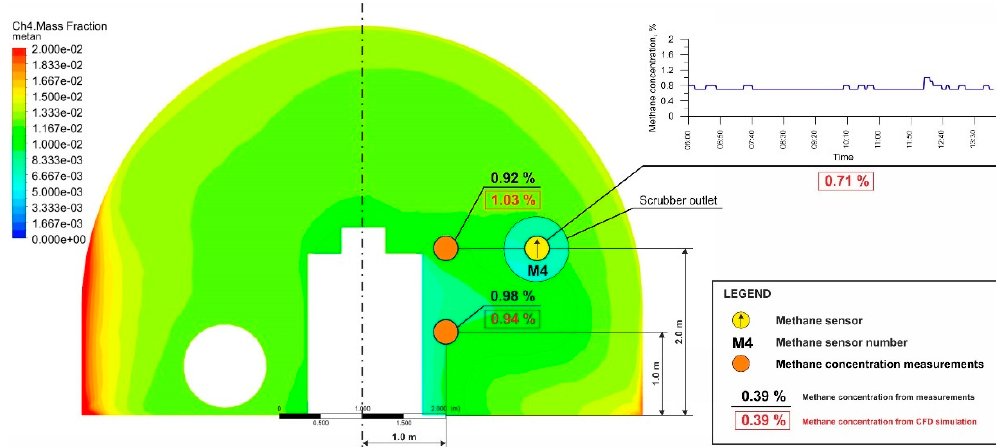
Figure 6. Distribution of methane concentration in the section of the roadway at a distance of 32 m from face with the location of the M4 methane sensor (at the scrubber outlet).